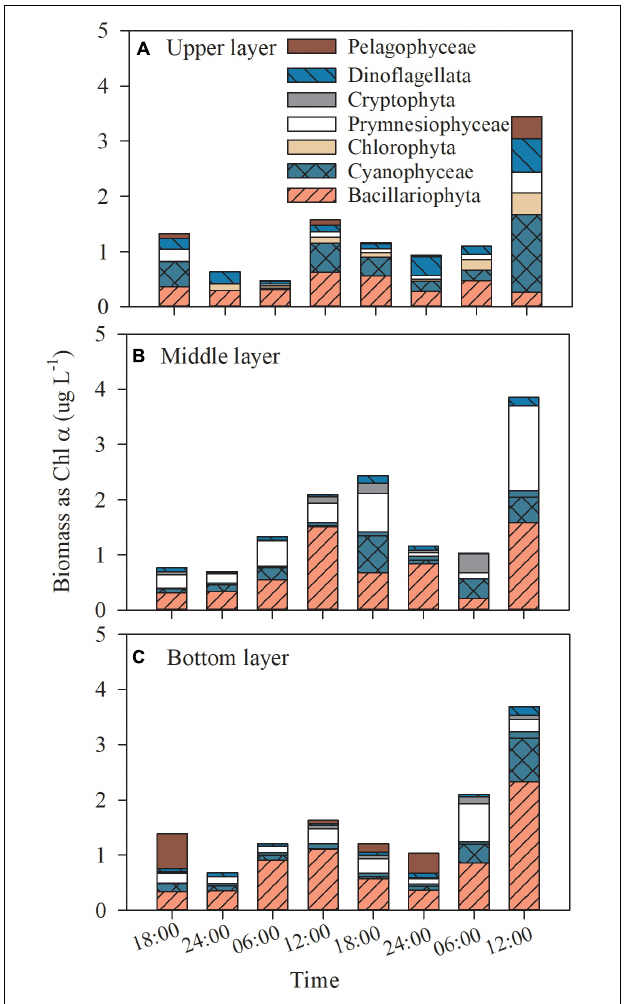
FIGURE 3 | Dial variation in the community composition of the phytoplankton assemblage in the upper layer (A) , the middle layer (B) , and the bottom layer (C) of Daya Bay during September 30 to October 2, 2014.